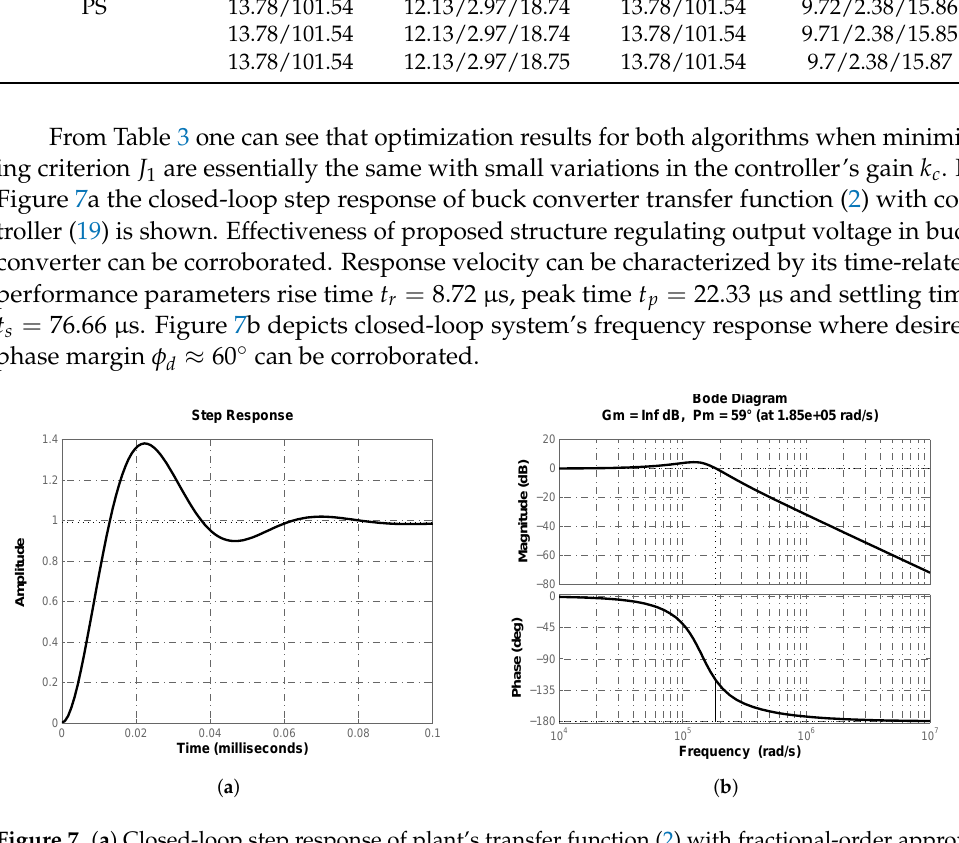
Figure 7. ( a ) Closed-loop step response of plant’s transfer function (2) with fractional-order approxi- mation (19). ( b ) Frequency response corroborating closed-loop phase margin φ d ≈ 60 ◦